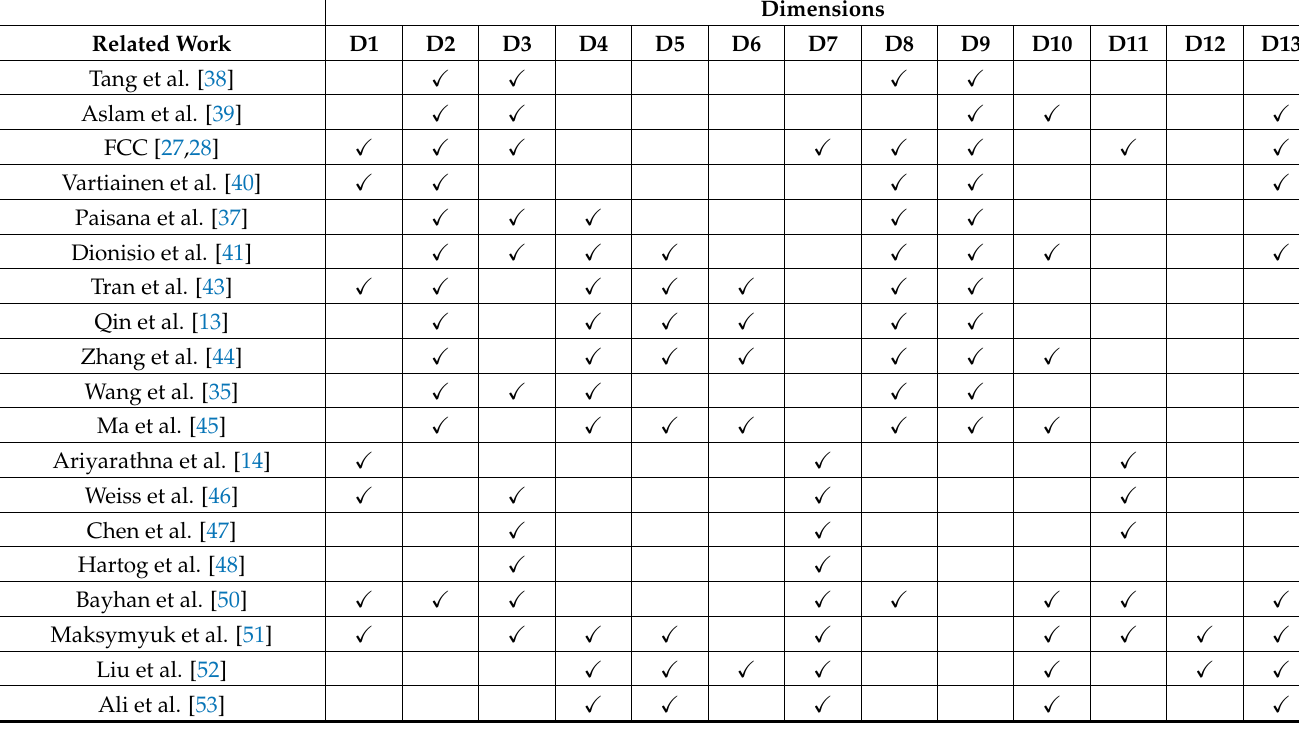
Table 2. Related work on DSA. Scope comparison with respect to: D1—Dynamic spectrum sharing and access policies; D2—Spectrum sensing; D3—Reliability, efficiency and consistency of spectrum information sharing and opportunistic decisions; D4—Realtimeness; D5—Low complexity and scalability; D6—Energy fingerprint; D7—Security and immutability; D8—Spectrum sensing coverage; D9—Location awareness; D10—Cost-effectiveness; D11—Spectrum market as a service; D12—AI and ML;